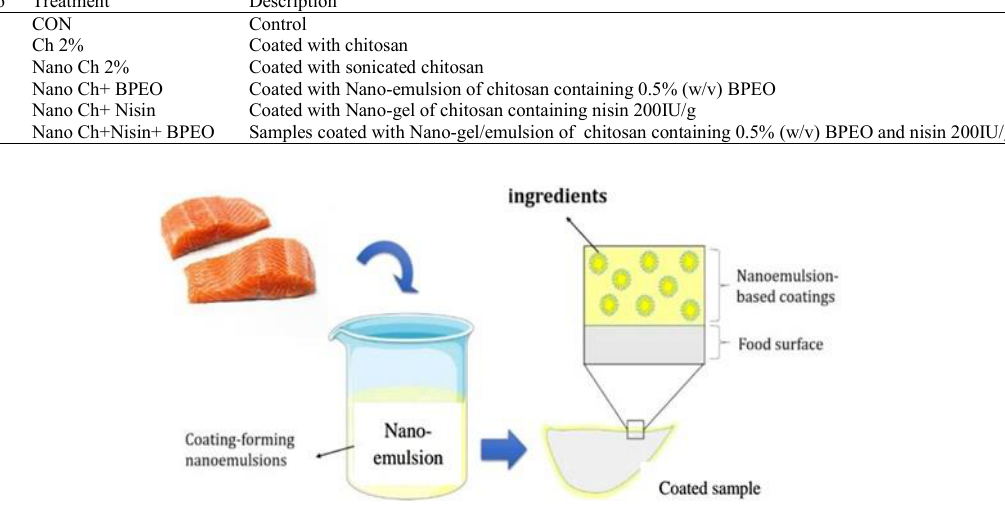
Fig. 2: Schematic of nano-emulsion coating on fresh rainbow trout fish